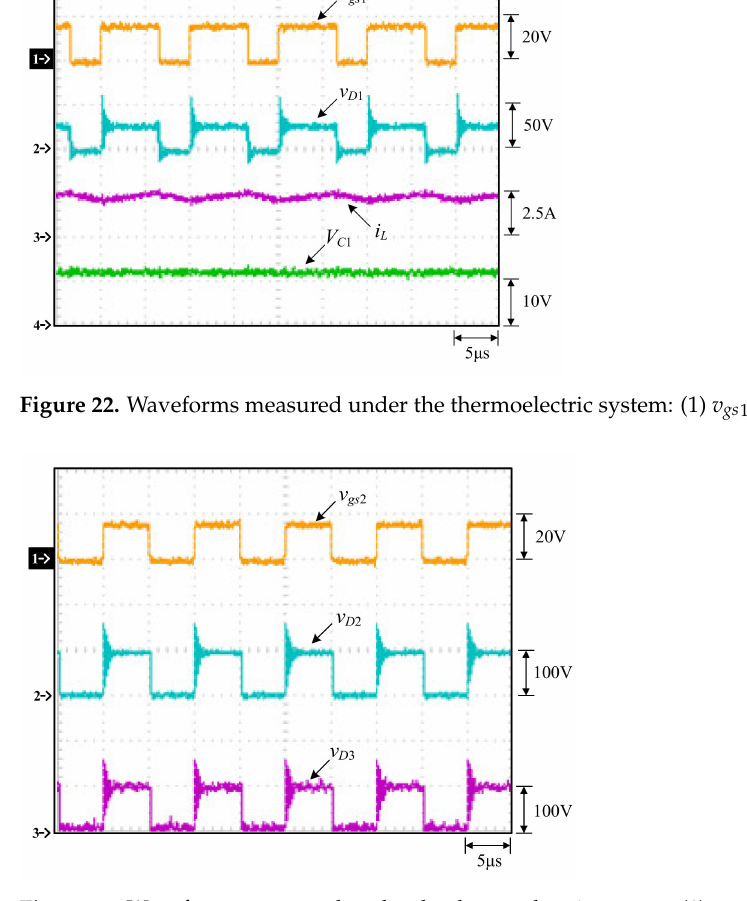
Figure 23. Waveforms measured under the thermoelectric system: (1) v gs 2 ; (2) v D 2 ; (3) v D 3 .